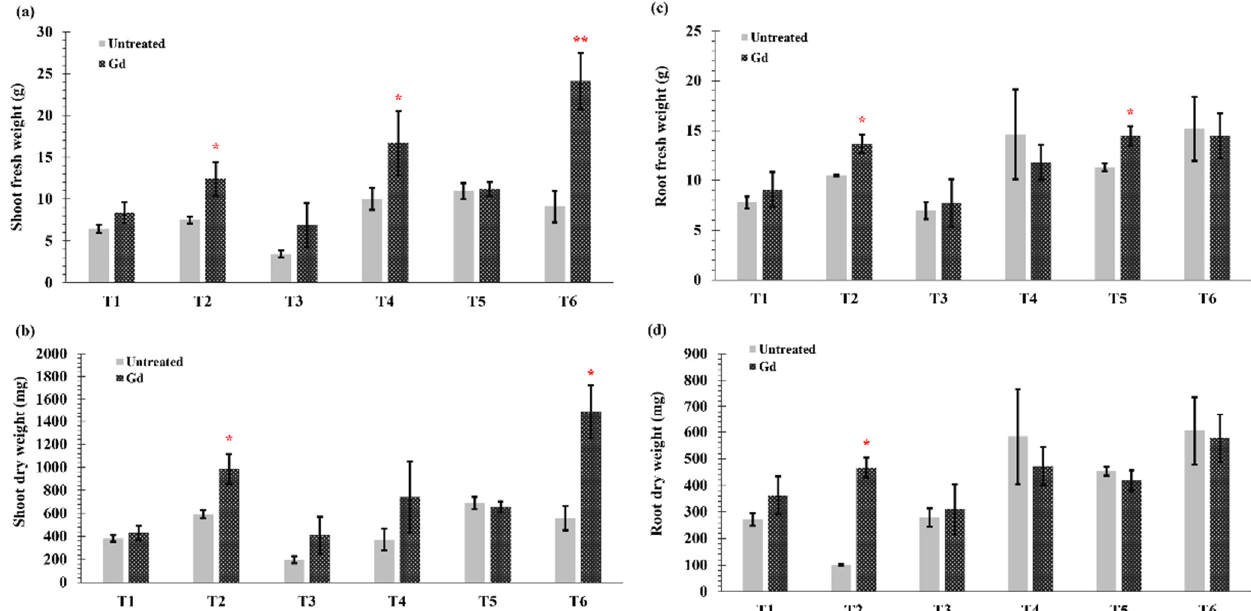
Figure 1. Evaluating the effects of severe water stress (35%-WHC; T1), moderate water stress (50%-WHC; T2), severe nitrogen stress (0 mg N pot − 1 ; T3), moderate nitrogen stress (150 mg N pot − 1 ; T4), combination of severe water stress and moderate nitrogen stress (35% WHC and 0 mg N pot − 1 ; T5), and combination of moderate water stress and moderate nitrogen stress (50% WHC and 150 mg N pot − 1 ; T6) on ( a ) Shoot fresh weight, ( b ) shoot dry weight, ( c ) root fresh weight, and ( d ) root dry weight of maize plants inoculated with Gluconacetobacter diazotrophicus Pal5 (Gd) in comparison with untreated plants. Bars represented means of three ( n = 3) replicates with standard errors (SEs). * and ** above bars indicate significance at p < 0.05 and p < 0.01 and bars without any * are non-significant ( p > 0.05).